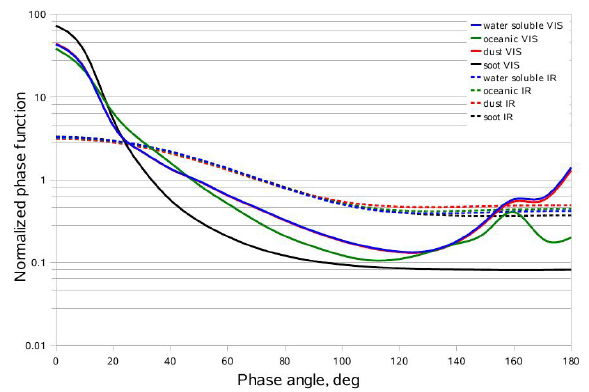
Fig. 2. Phase functions for accumulation mode of oceanic, wa- ter soluble, dust and soot aerosol components calculated spherical polydisperse particles at 550nm (VIS, continuous line in the figure) and 3.7µm (IR, dashed line in the figure). The phase functions are normalized to unity, see SSA in text.